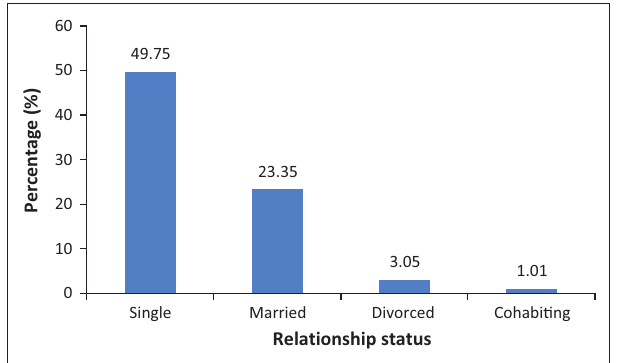
FIGURE 2: Participants’ relationship status.